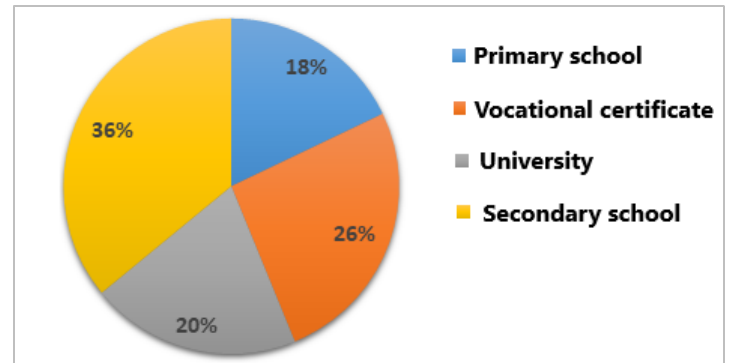
Figure 5. Respondents’ education.